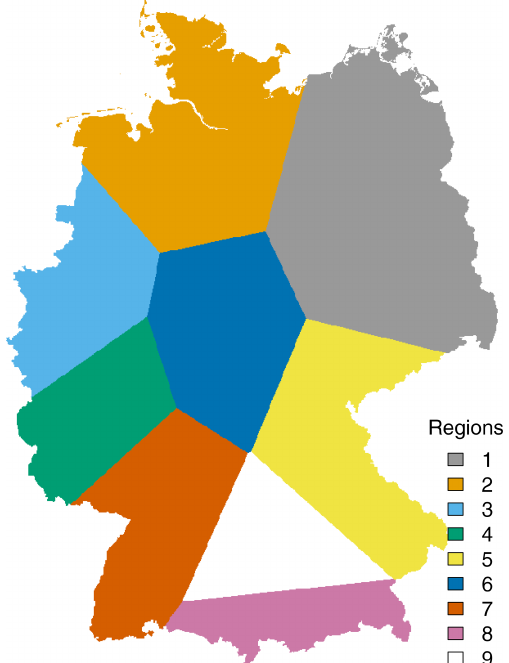
Figure 9. Nine homogeneous regions implemented here for the index-based regionalisation. The regions shown here are a gener- alisation of the k -cluster results to account for spatial